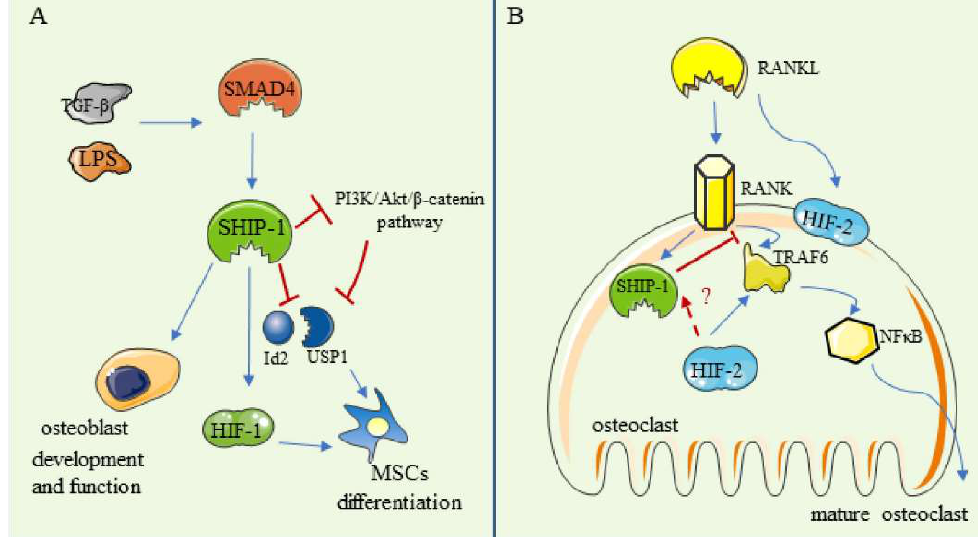
Figure 6. SHIP-1 Signaling. ( A )The regulation in osteoblasts and MSCs. SHIP is involved in the de- velopment and function of osteoblasts directly. SHIP-1 stabilizes the expression of HIF-1 and regu- lates the differentiation of MSCs. ( B ) The regulation in osteoclasts. SHIP-1, downstream of RANK, negatively regulates the activity of osteoclasts. HIF-2α can directly up-regulate TRAF6 and increase osteoclastogenesis.